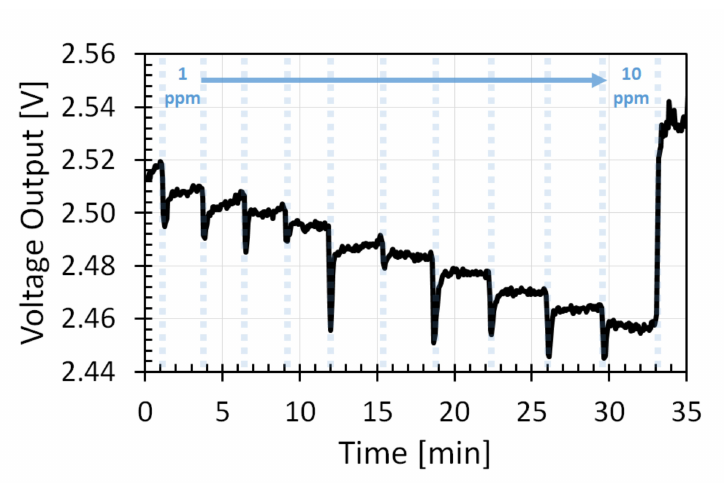
Figure 8. Ethanol measurements at low concentrations over Pt nanoparticle layer. Gradual addition of 1 ppm of ethanol to the chamber from 1 to 10 ppm. Voltage output signal with 20 dB gain at heater-voltage amplitude applied to heating resistor of 3.0 V.